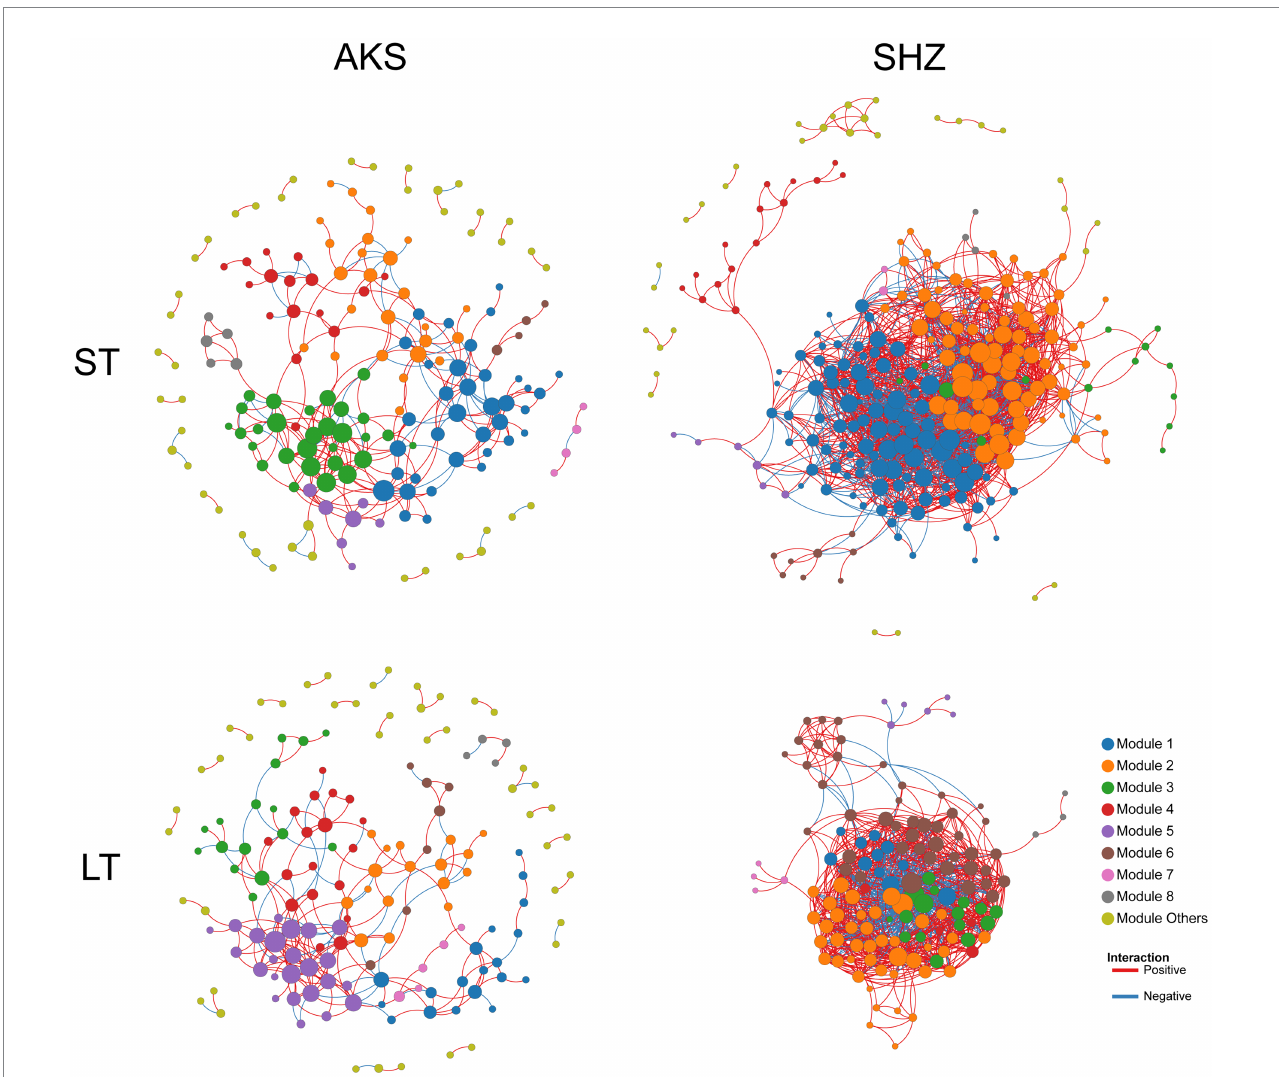
FIGURE 6 Co-occurrence networks of bacterial communities in cotton field soil samples under short-term continuous cropping (ST) and long-term continuous cropping (LT) in AKS and SHZ soils. ST is the sample summary of 1, 3, 5, and 8 years of continuous cropping. LT is the sample summary of 8, 10, 15, and 20 years of continuous